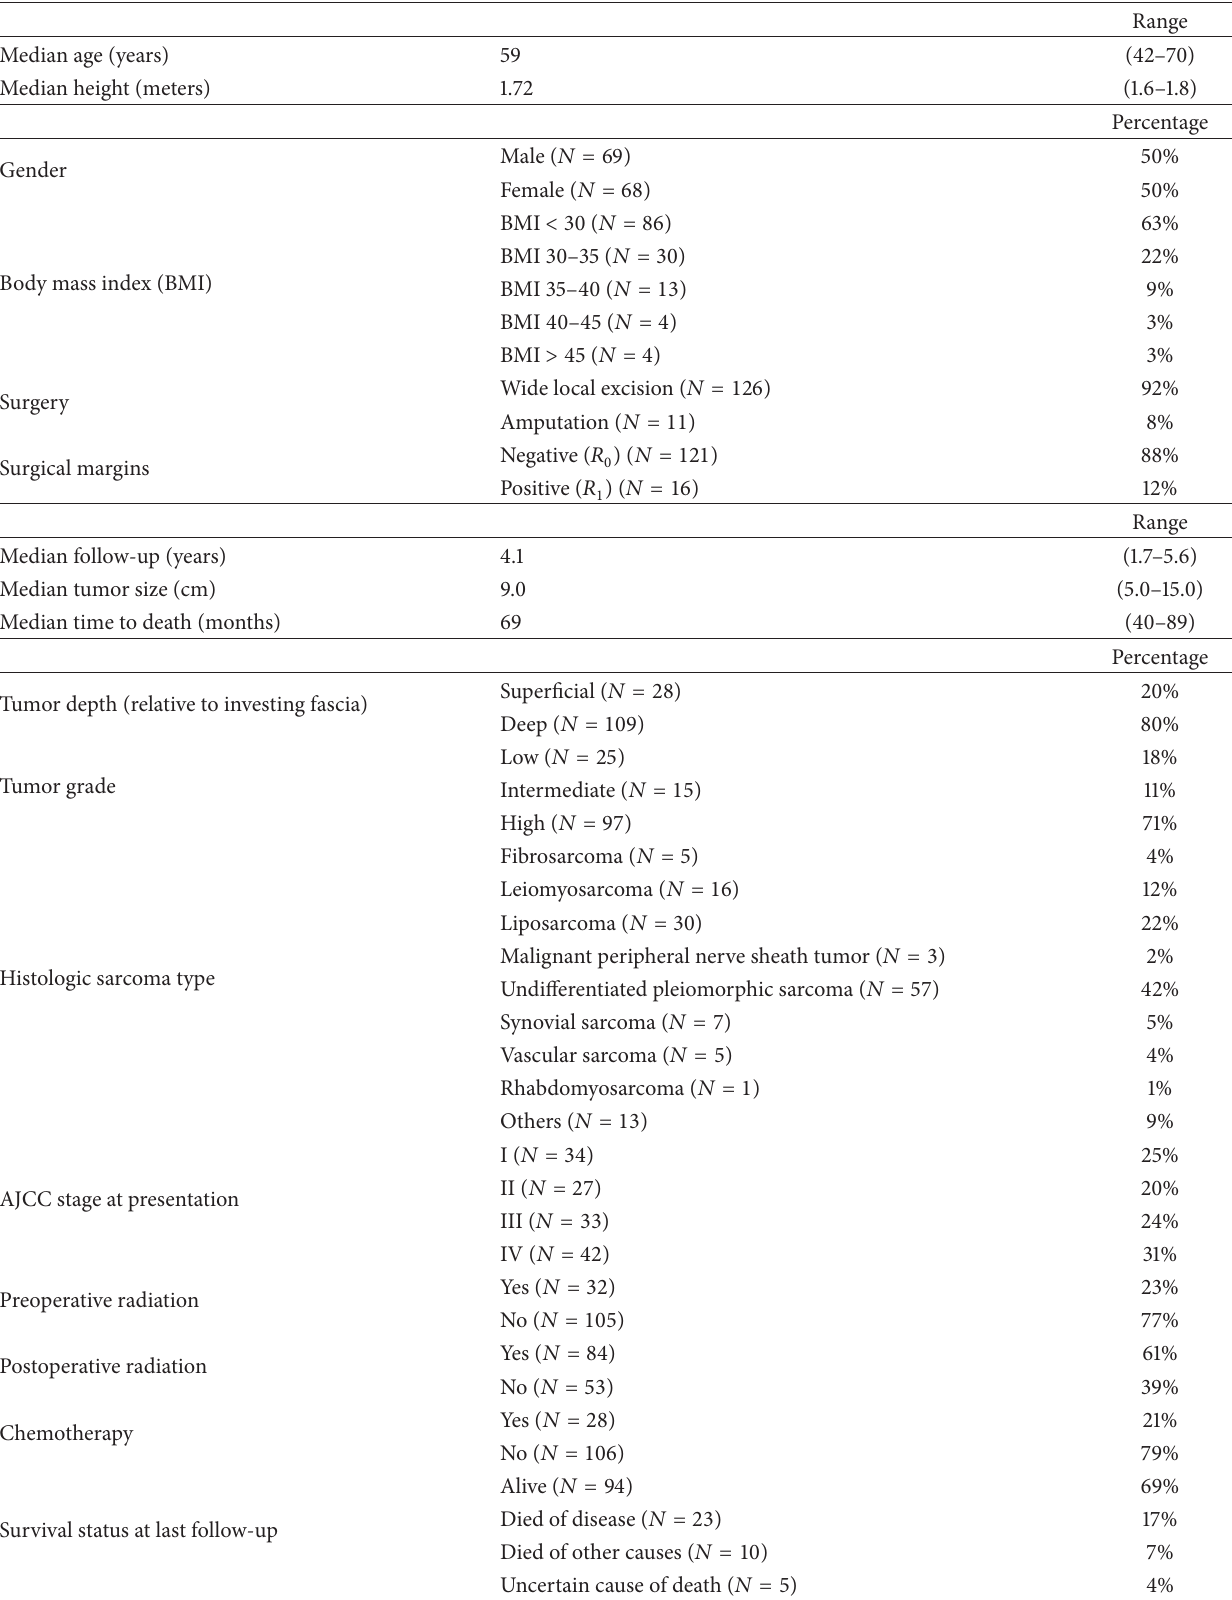
Table 1: Demographic and clinical